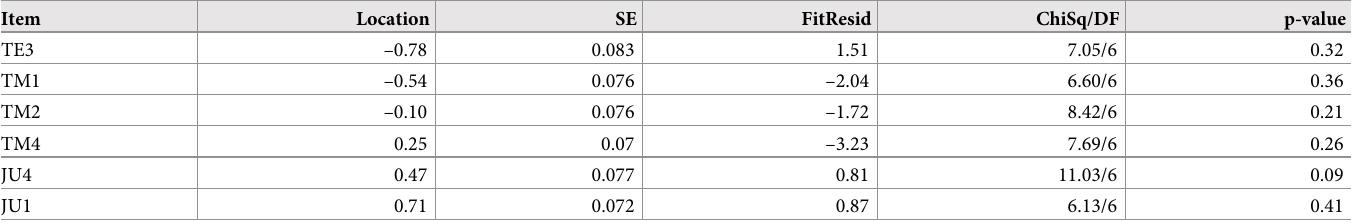
Table 5. Item locations, standard errors, item fit residuals, item Chi Square statistics, degree of freedom and p-values for the six items of the Workplace Social Cap- ital scale of the COPSOQ III.